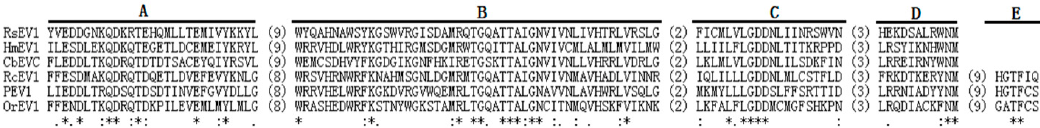
Figure 3. Phylogenetic analysis of RsEV1 and other endornaviruses based on the deduced amino acid sequences of RdRps using the maximum likelihood (ML) method with 1000 bootstrap replicates. The scale bar indicates a genetic distance of 0.5 amino acid substitutions per site. The green box represents the novel mycovirus RsEV1 in this study. The abbreviations of viruses and their GenBank accession